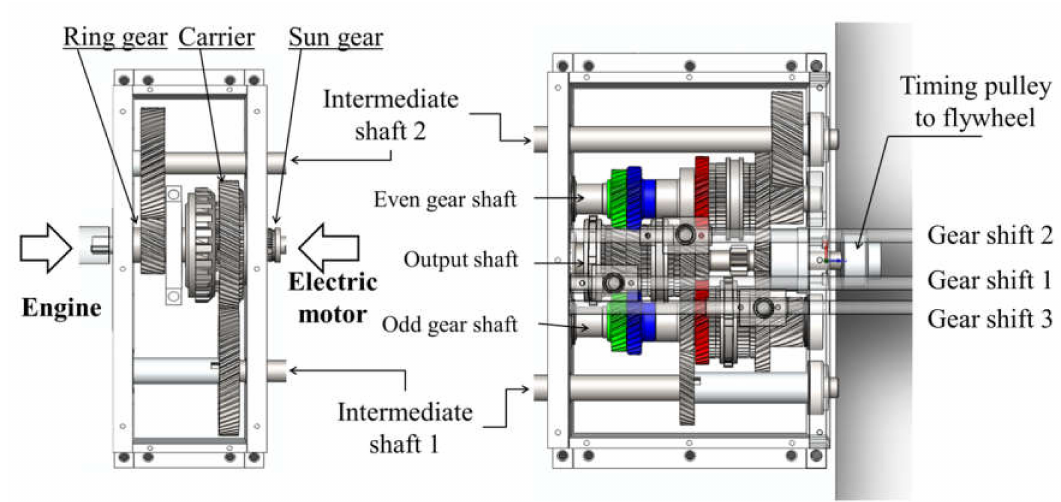
Figure 9. Schematics of the planetary gear-set (PGS) (left) and a dual input gearbox (right) of the